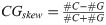
Features of the nucleotide consensus around TSS.A top left) Frequency of CA, B top right) Frequency of TATA motif, D middle feft) Frequencies of nucleotides A, C, G, T around TSS for Fgenesh, E middle right) Frequencies of A, C, G, T around TSS for MSU, F bottom) CG skew (CGskew=#C−#G#C+#G), calculated in the window of 40 nt.